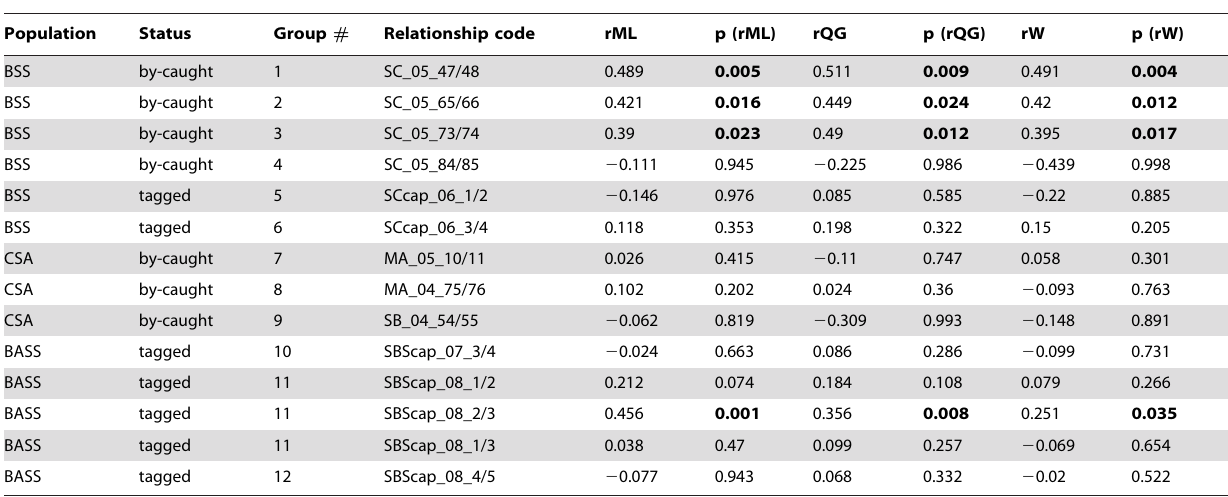
Table 3. Estimated relatedness for all groups of